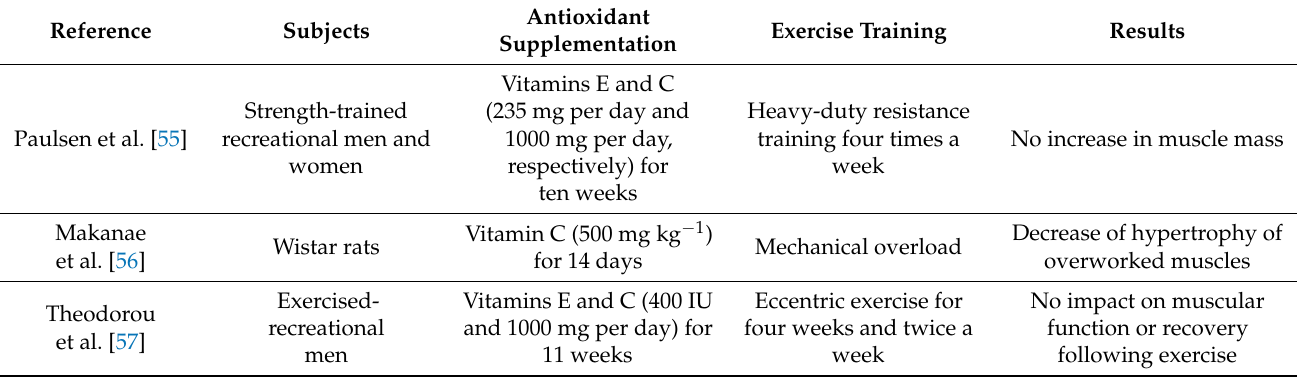
Table 1. The influence of antioxidant supplementation on skeletal muscle (adaptations to training, inflammation, mus- cle